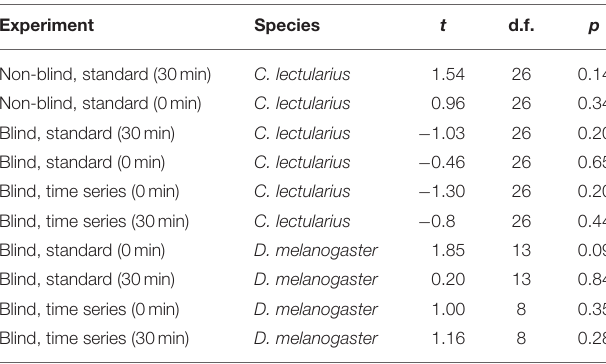
TABLE 2 | Pearson correlation of total number of sperm and proportion of live sperm (sperm viability, SV) in Cimex and Drosophila for the different experiments. Experiment